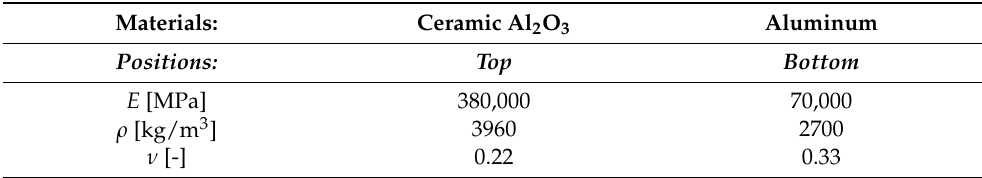
Table 2. Layer material properties for k = 0.05.